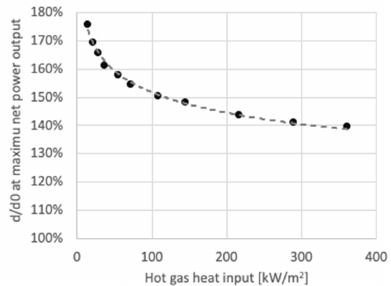
Figure 5. Optimum thermoelectric leg length d relative to the optimum d 0 for the constant tempera- ture case. All data points are the results for the matched heat capacity between the hot gas and cold water ( C g = C w ) . Cold-side temperature T c is nearly the same as T a due to the very high heat transfer coefficient at the cold side (water cooling) compared to the hot